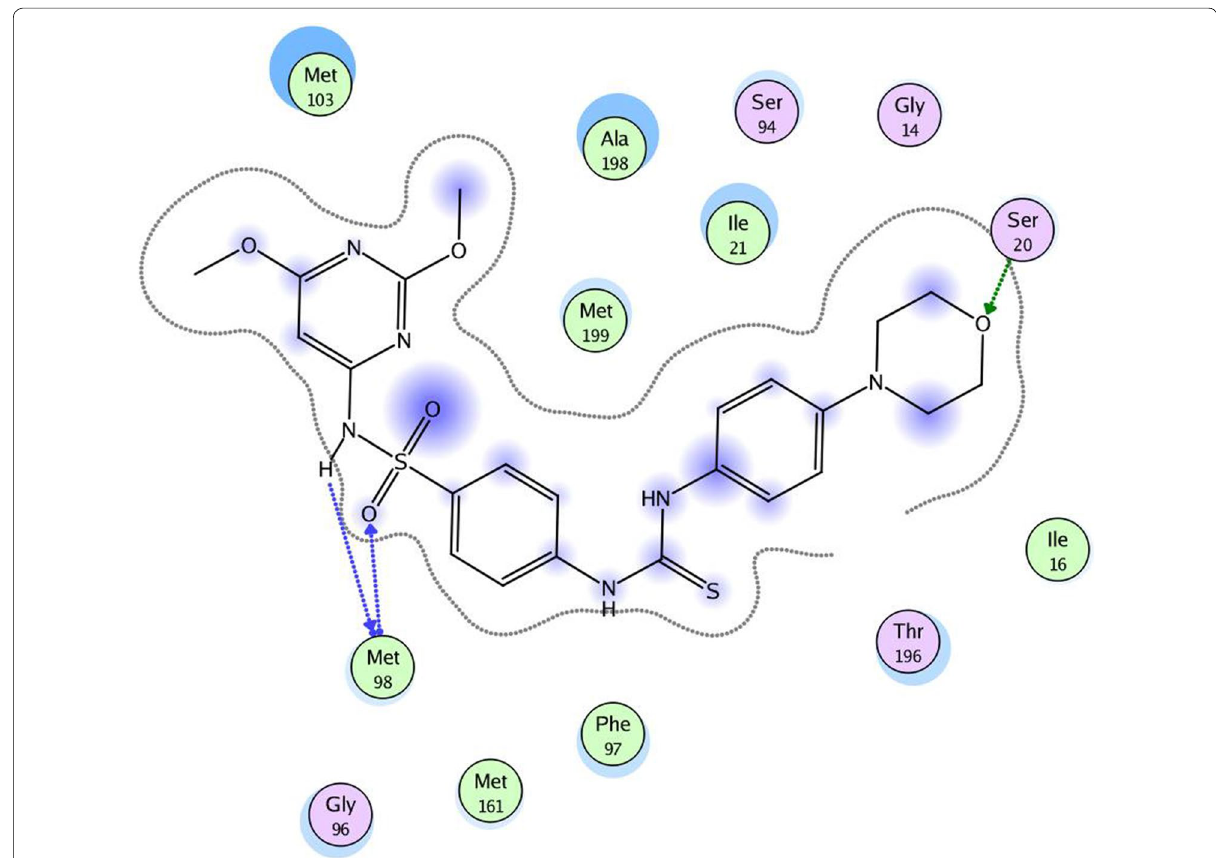
Fig. 4 2D interactions of compound 3s with the active site amino acids of 5JFO